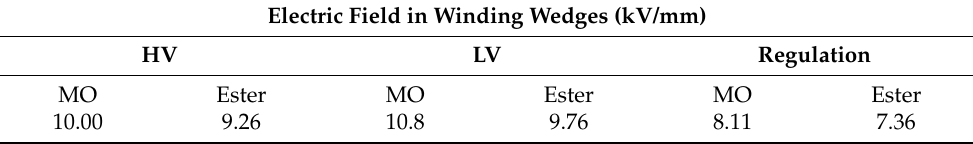
Table 6. Case 3—mineral oil versus ester: comparison.